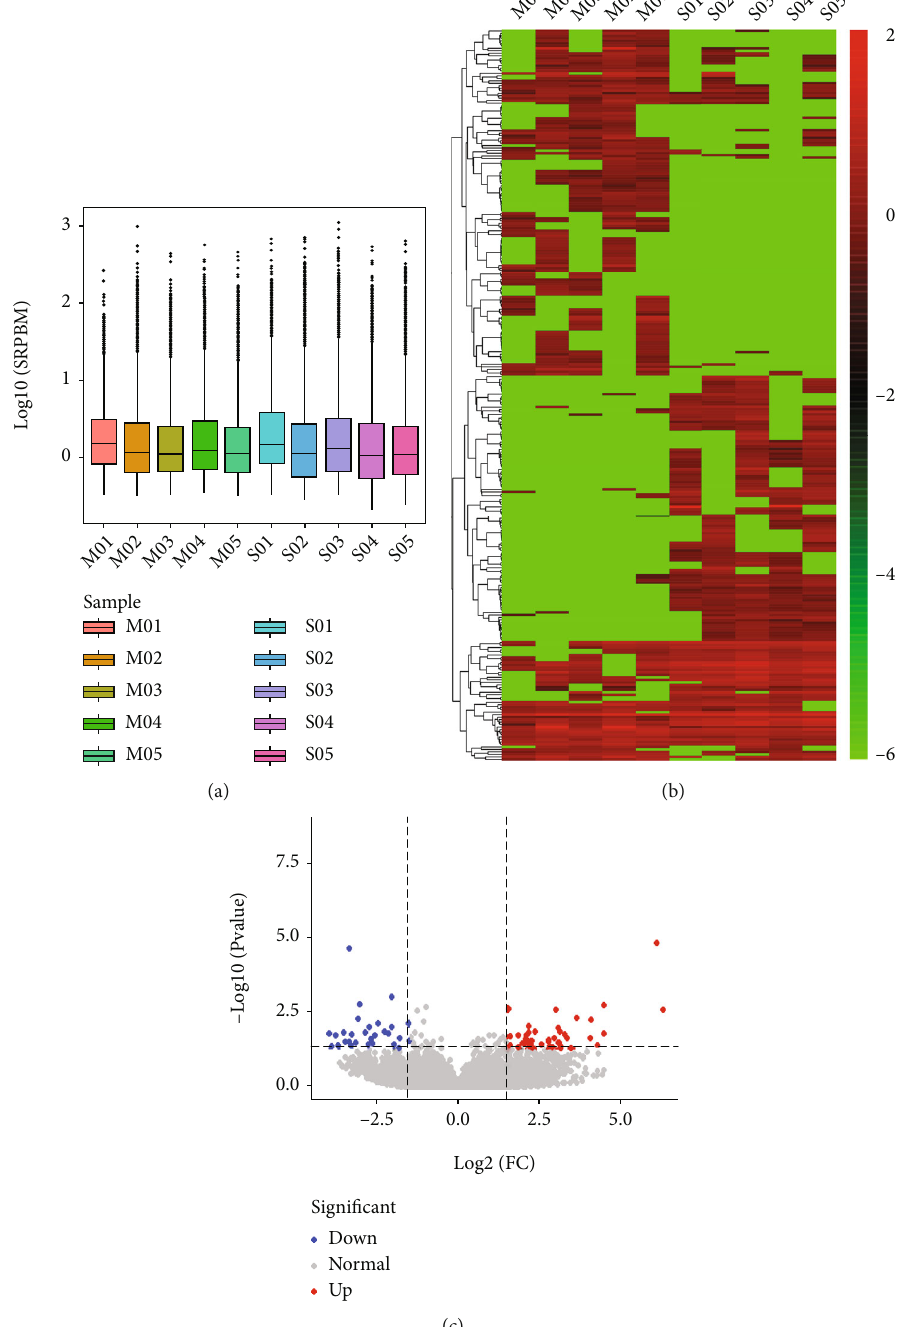
Figure 2: Expression analysis of circRNAs between the MCAO and sham groups. (a) Box plot describing expression abundance of circRNAs in each sample. The x -axis represents the sample, and y -axis the logarithm value of normalized sample expression with the spliced reads per billion mapping algorithm. (b) Volcano plot exhibiting DECs between the two groups. Blue and red dots represent downregulated and upregulated DECs in MCAO compared to the sham group ( P < 0 : 05 ), respectively. Gray dots represent circRNAs with equal expression level between the two groups. (c) Clustering heat map illustrating distinguishable expression pro fi les of circRNAs between the two groups. Red and green colors represent fold changes of upregulated and downregulated circRNAs, respectively, whereas black signi fi es circRNAs with unchanged expression levels. The colors from green to red indicate increased relative circRNA expression. M01 – 5: cortex samples in the MCAO group; S01 – 5: cortex samples in the sham